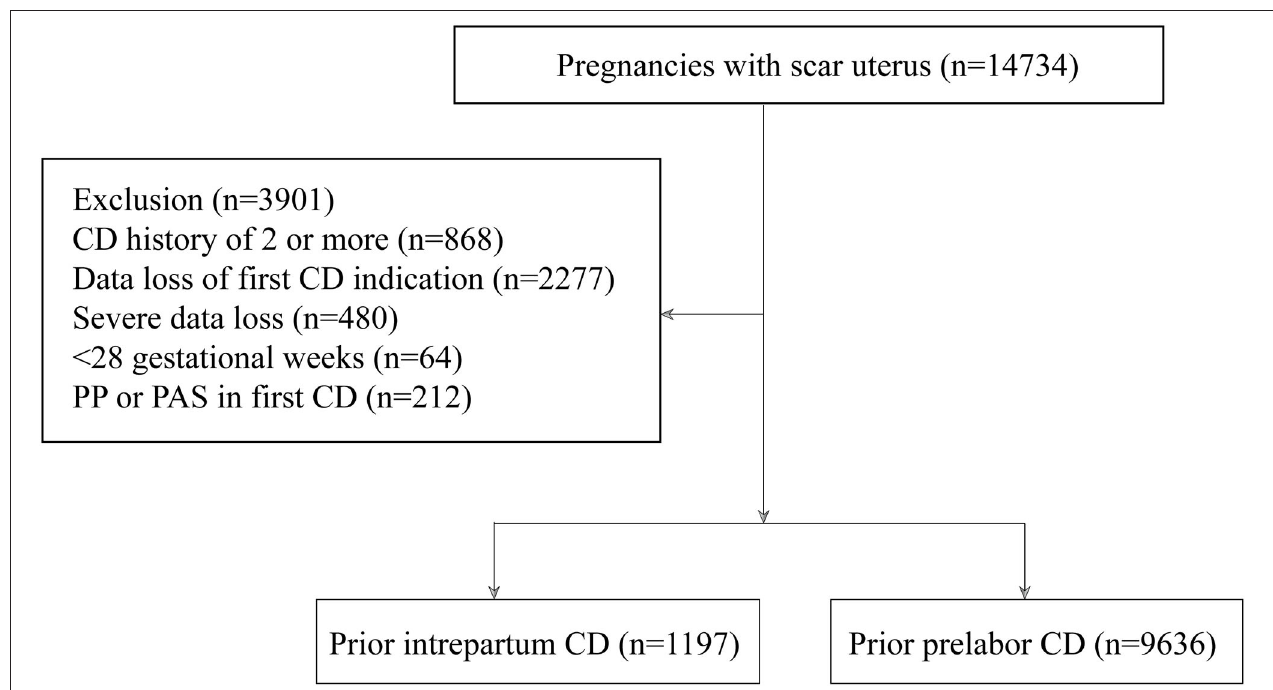
FIGURE 1 | A flow diagram of the enrollment process of the